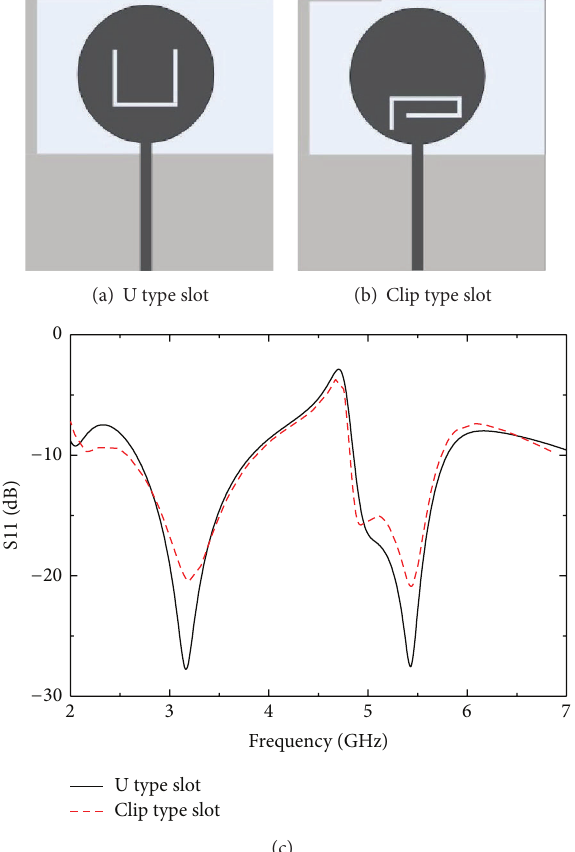
Figure 4: The performance of band-notch formation for two type slots.